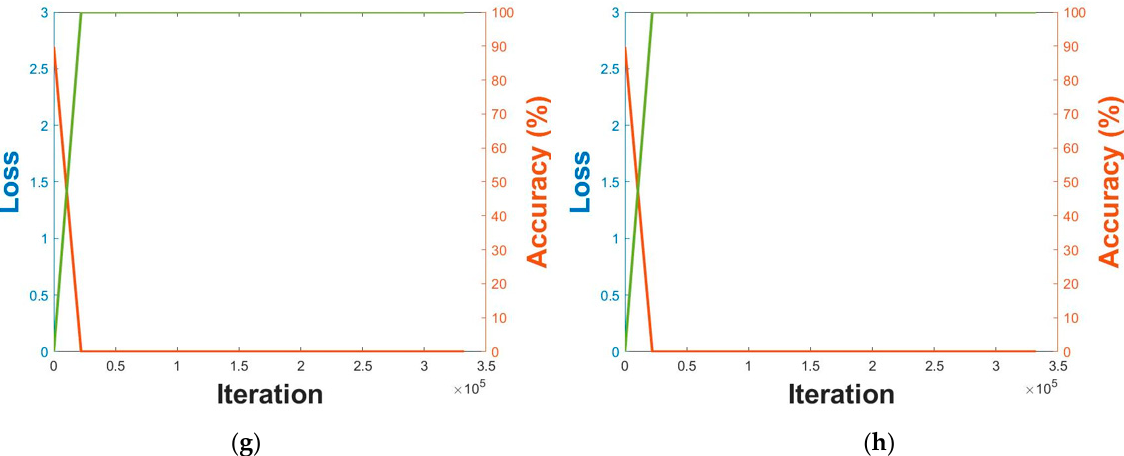
Figure 6. Graphs illustrating training accuracy and loss of DFB-DB3 ( a – d ) result and ChokePoint dataset ( e – h ) result. VGG face net-16 with respect to ( a ) and ( e ) the first fold and ( b ) and ( f ) the second fold. ResNet-50 with respect to ( c ) and ( g ) the first fold and ( d ) and ( h ) the second fold.